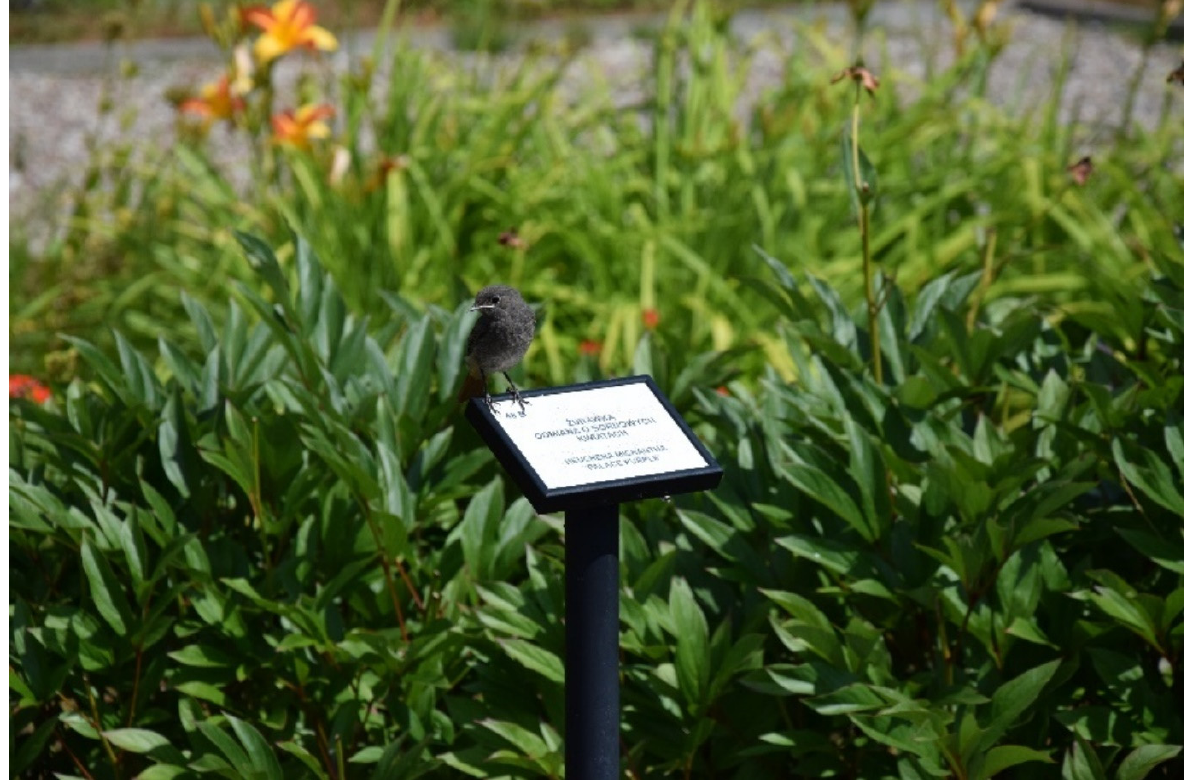
Figure 5. Waypoints described in Braille, Owi ń ska (Fot. A. Zajadacz).